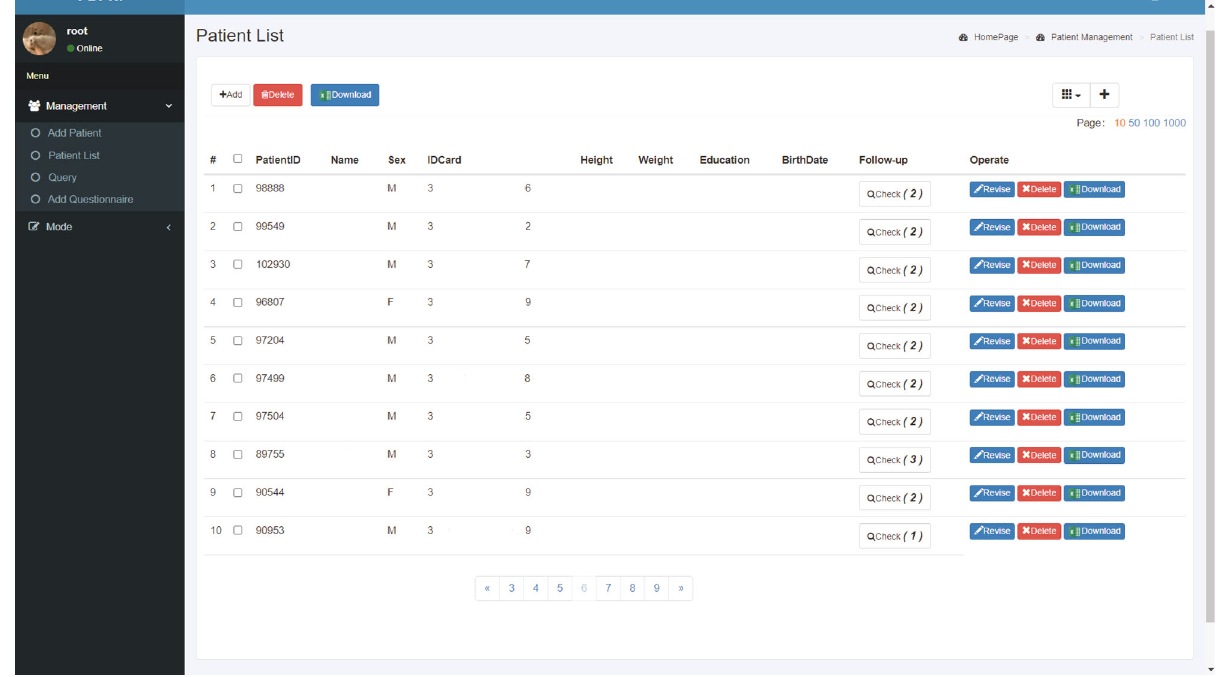
Figure 2: PDPNI website interface-patient information list. Table 4: Sample distribution of research cohorts and healthy subjects.